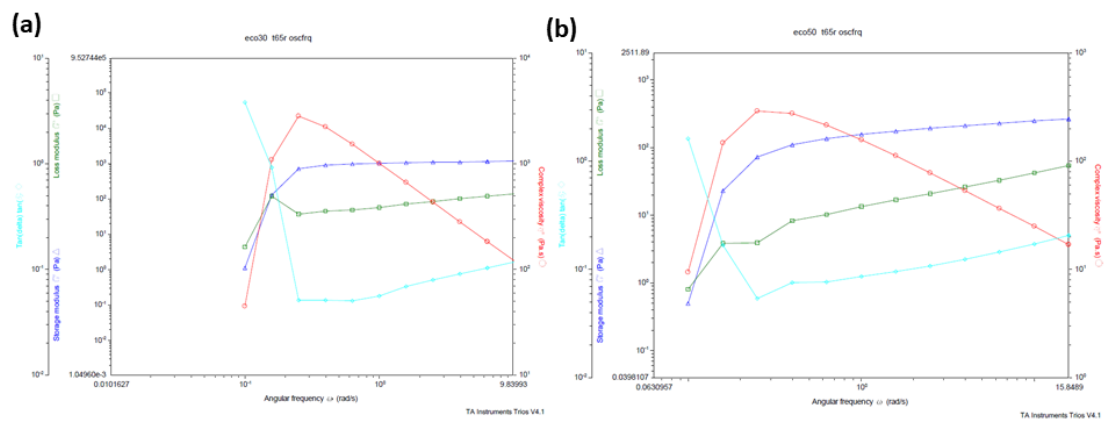
Figure 4. ( a ) Eco30 and ( b ) Eco50 storage modulus, loss modulus, complex viscosity vs angular frequency.